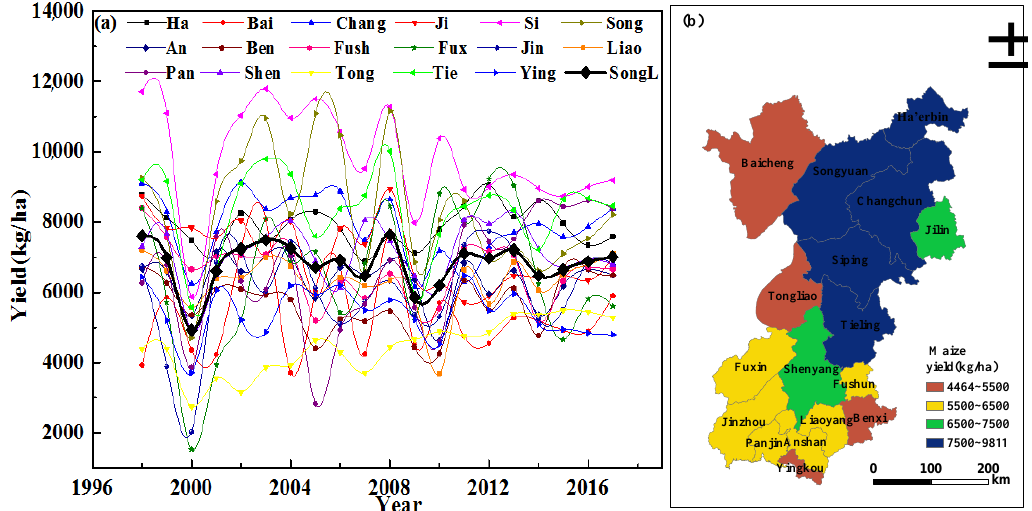
Figure 6. ( a ) Fluctuation in maize yield and spatial distribution ( b ) of maize yield in prefectural regions in the Songliao Plain maize belt during the period 1998–2017. Note: Ha (cid:48) erbin: Ha, Baicheng: